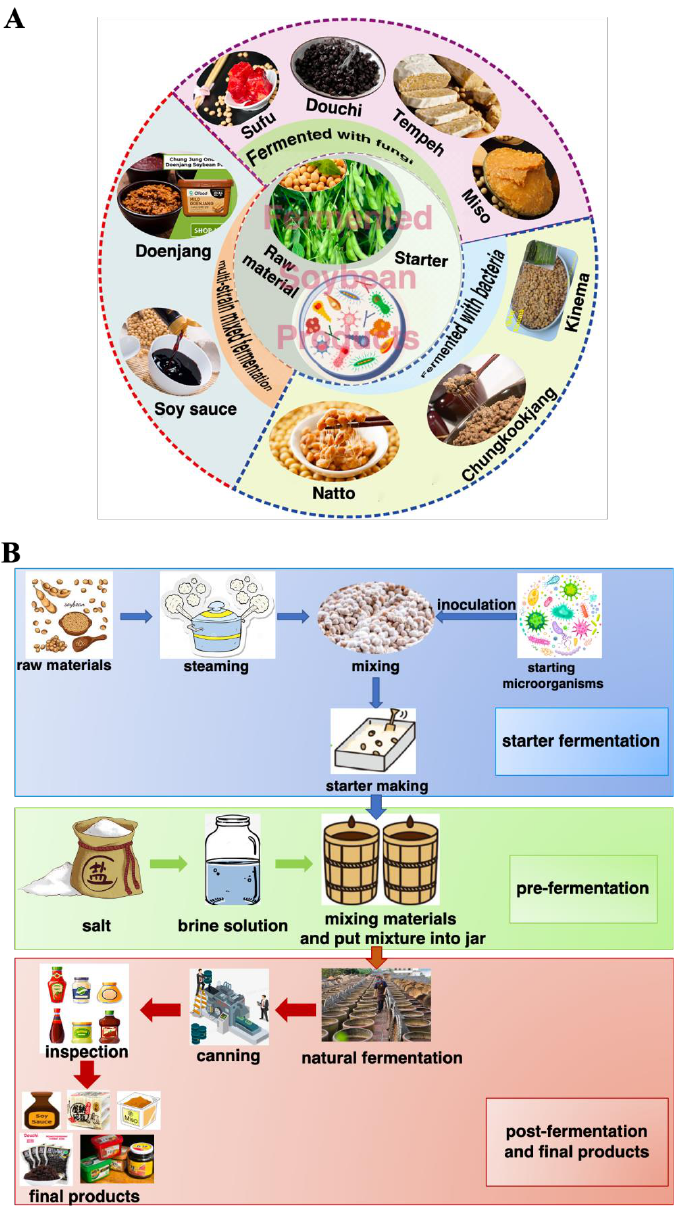
Figure 2. Fermented soybean products ( A ) and their production process ( B ).